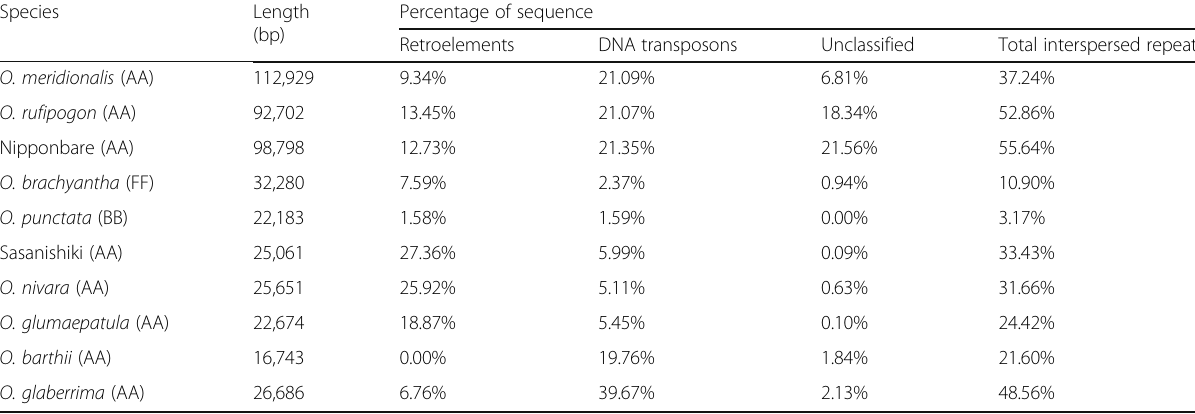
Table 2 Interspersed repeat sequence analysis of divergent structures in the Pi54 locus